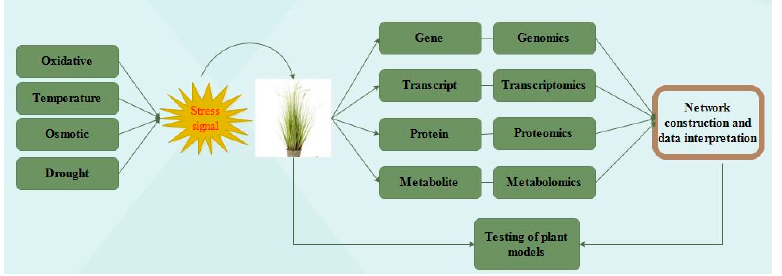
Figure 3. General outline of ‘omics’ approach for network construction, data interpretation and model testing. Schematic diagram of successful methods for the genome wide transcript expression profiling and is being widely used to generate transcriptional profiles.